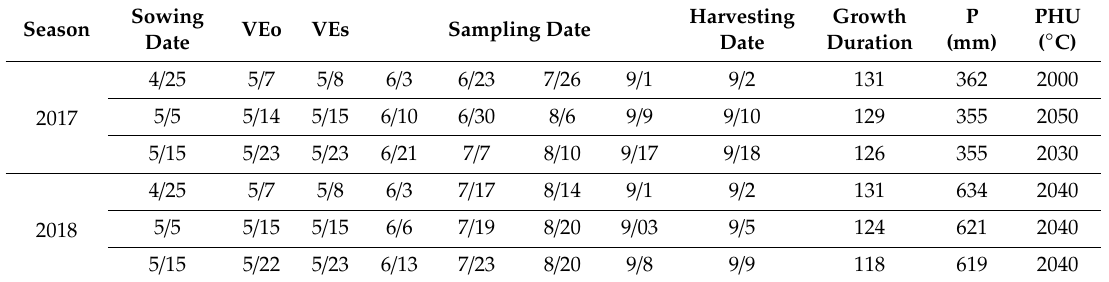
Table 2. Agronomic and potential heat unit (PHU) data of peanut in 2017 and 2018.